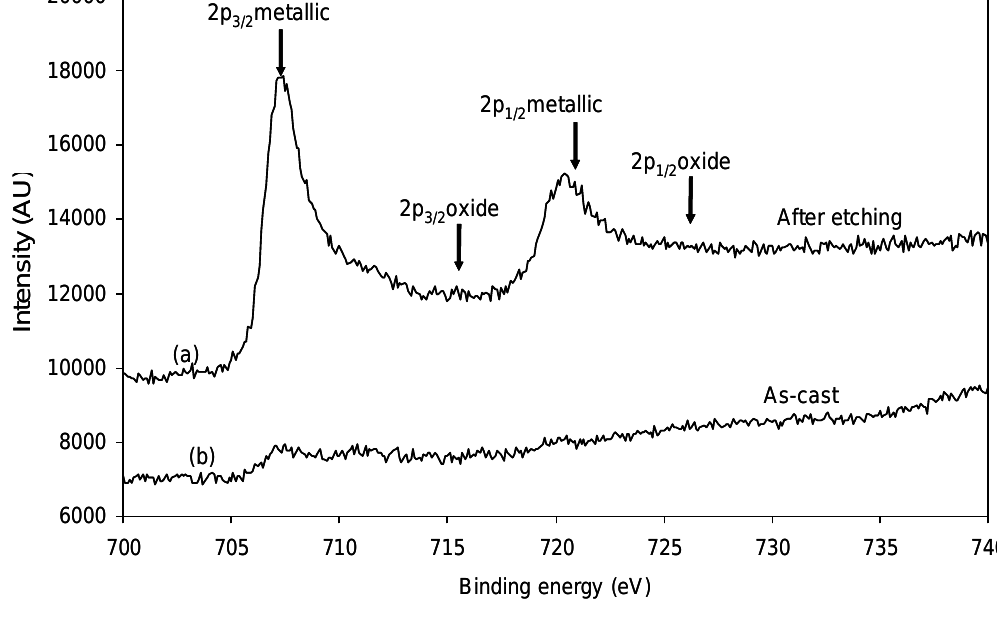
Figure 8. XPS Fe 2p in as-cast and after Ar + sputtering.